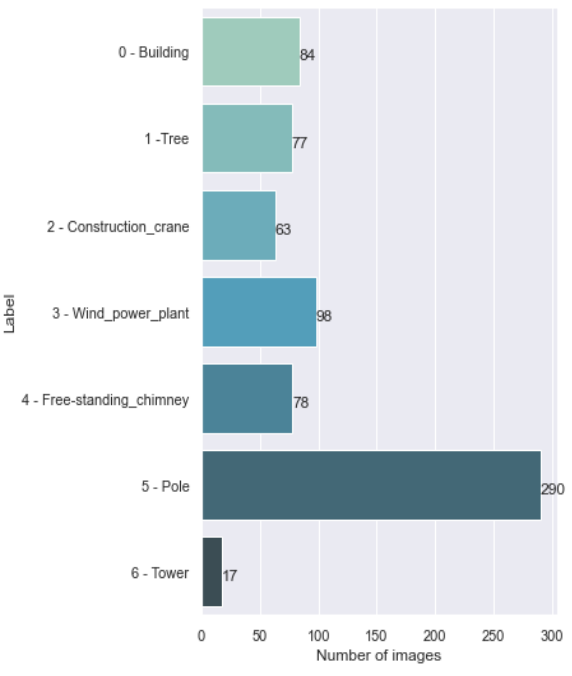
Figure 5 . Classes and number of images in new dataset.